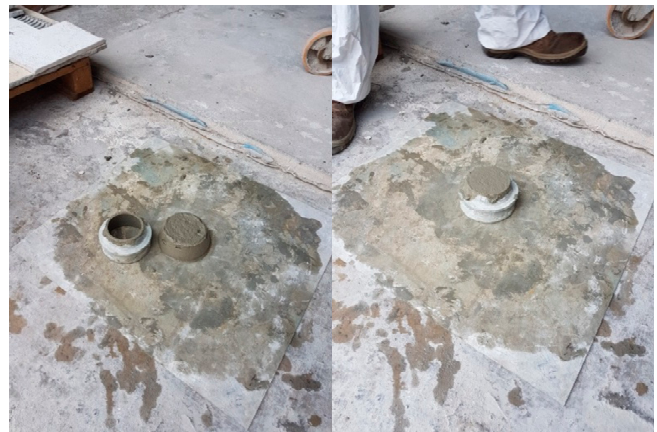
Figure 8. Spreading test results. No loss of shape is shown.